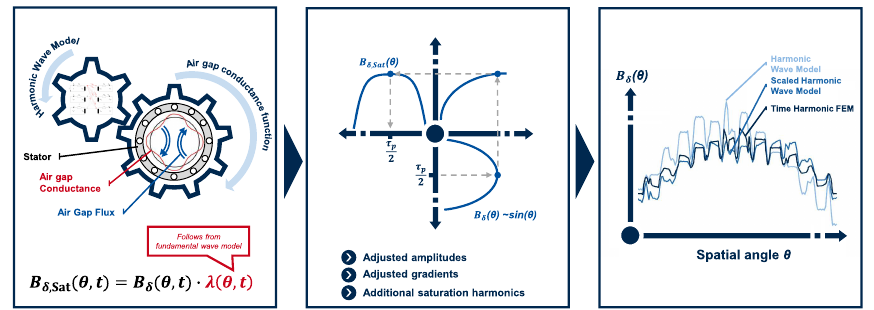
Figure 4. Approach of the consideration of saturation in the